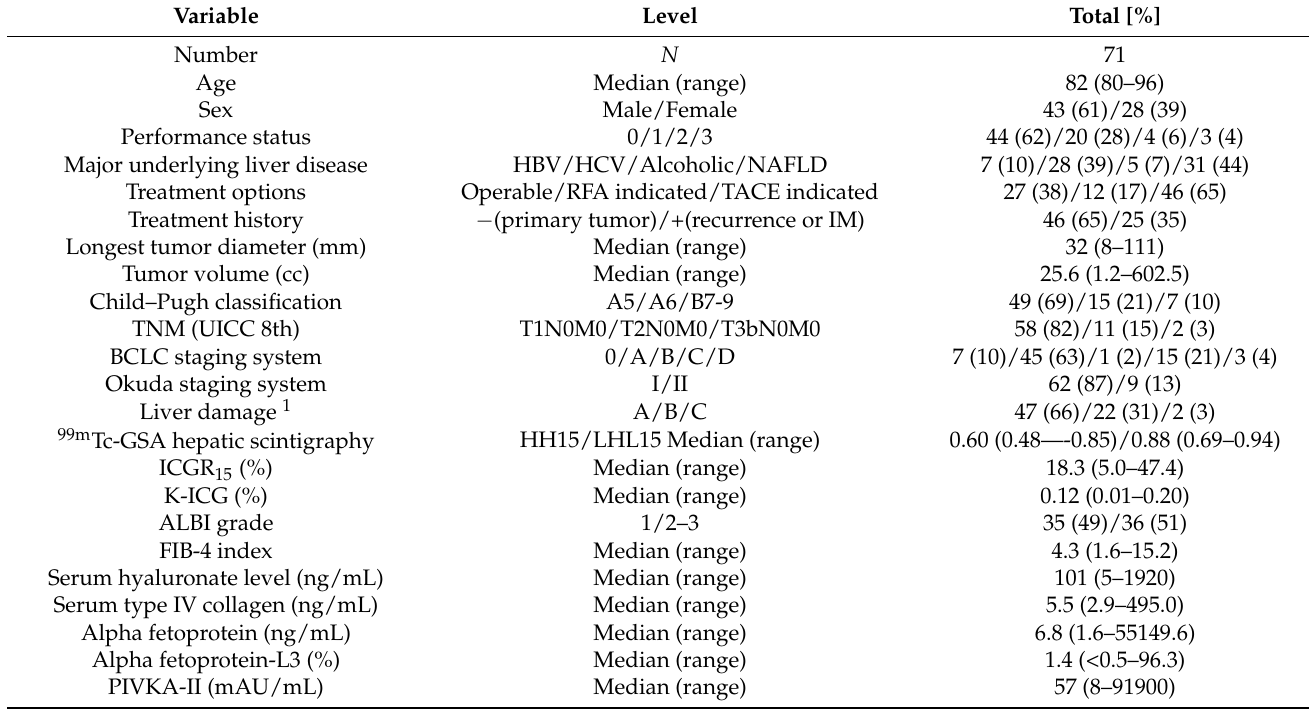
Table 1. Patient and tumor